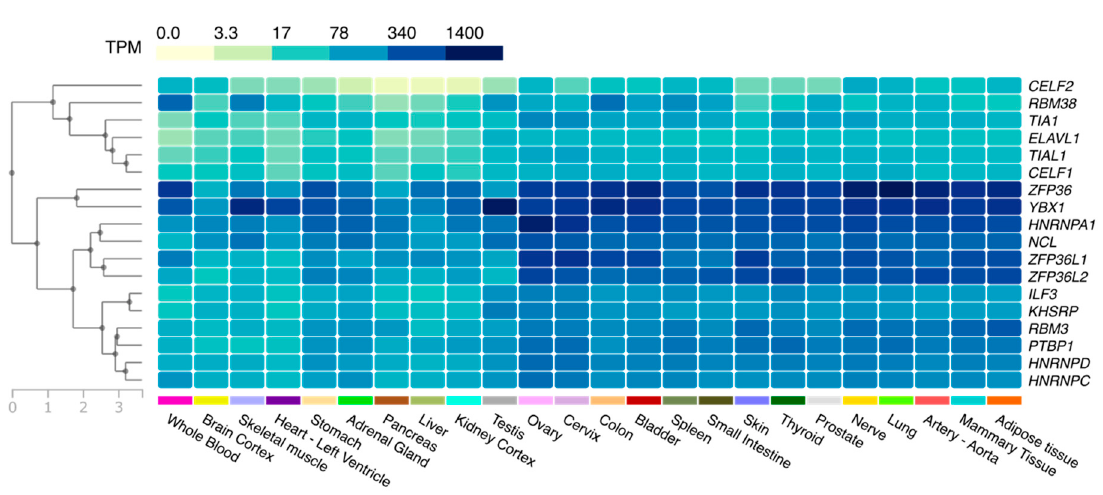
Figure 2. Tissue distribution of AU-rich element-binding proteins (AUBPs). A heat map representing the hierarchical clustering (left) of the mean relative expression (transcripts per million (TPM)) of AUBPs in different tissues and organs. The data used for the analyses were obtained from the Genotype-Tissue Expression (GTEx) project’s portal (https://www.gtexportal.org/home/) on 24 June 2020.